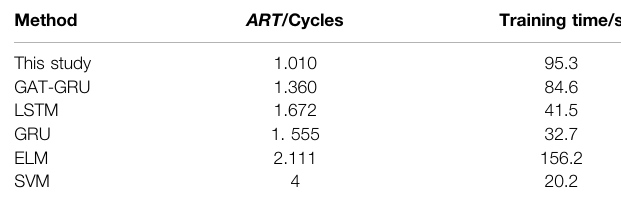
TABLE 3 | Average evaluation time versus training